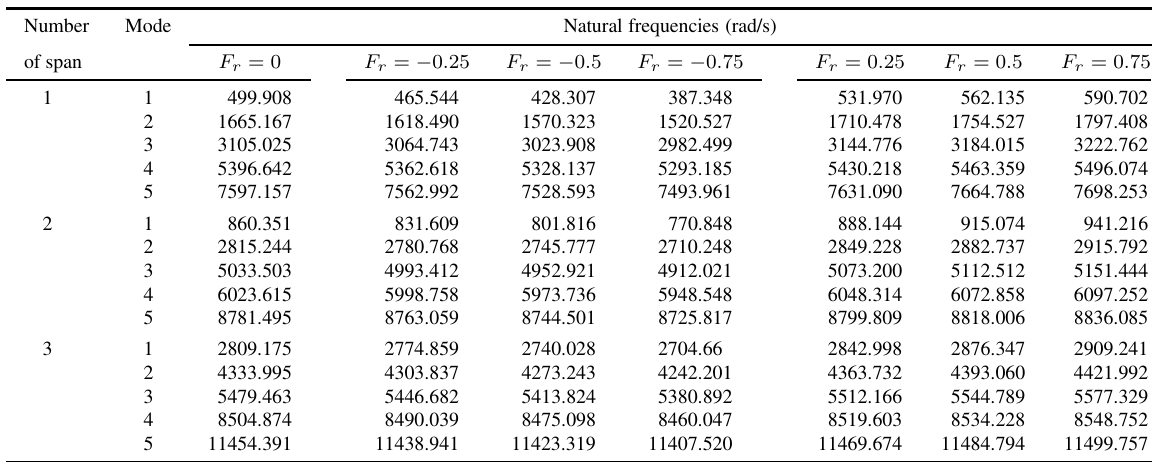
Table 2 The lowest five natural frequencies of the beam used in example